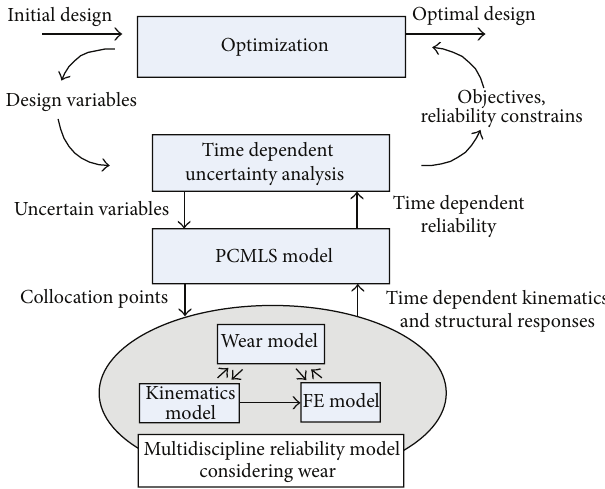
Figure 3: Procedure of time-dependent RBDO considering wear.